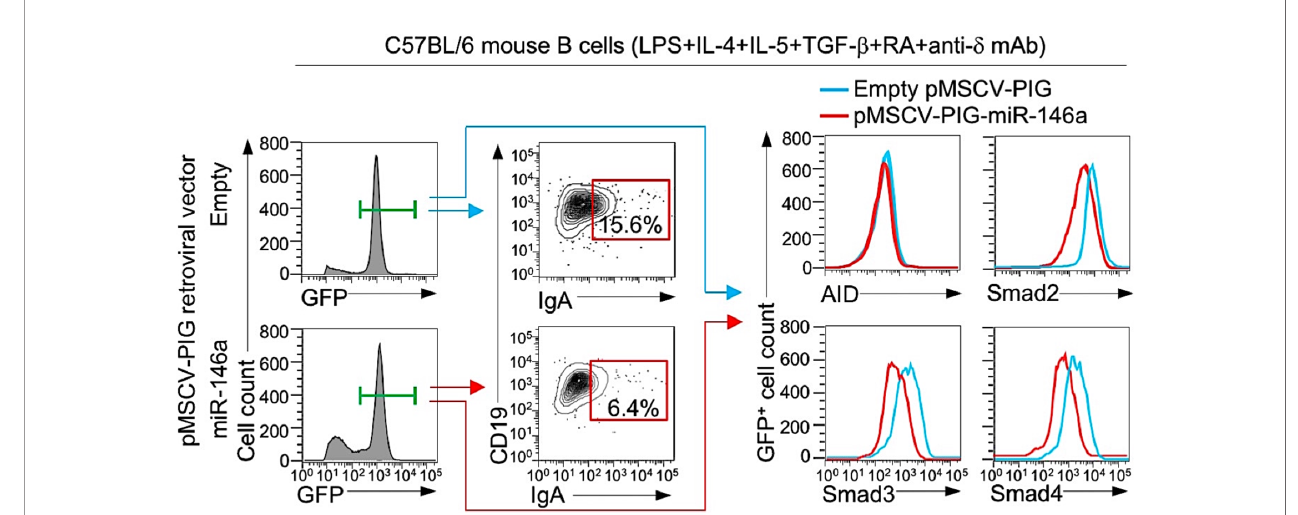
FIGURE 9 | Enforced expression of miR-146a in B cells reduces Smad2, Smad3 and Smad4 expression and CSR to IgA. B cells isolated from C57BL/6 mice were transduced with pMSCV-PIG-miR-146a retroviral vector expressing GFP and miR-146a or empty pMSCV-PIG retroviral vector that expression GFP, then stimulated with LPS plus IL-4, IL-5, TGF- b , anti- d mAb and RA and cultured for 96 h. Proportions of surface IgA + B cells, and intracellular AID, Smad2, Smad3 and Smad4 levels among the retroviral vector-transduced (B220 + GFP + ) B cells were analyzed by fl ow cytometry. Data are from one representative of three independent experiments.